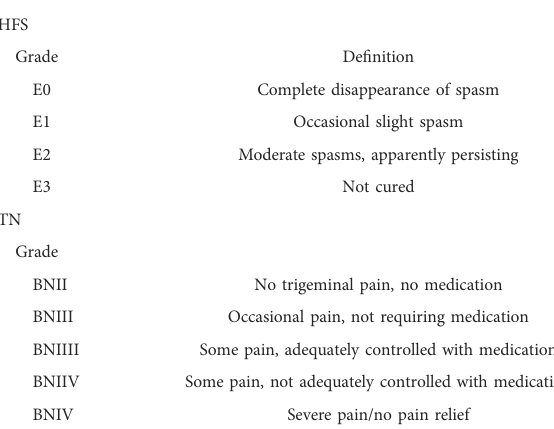
Table 4 . The correlation coef fi cient was − 0.1601 ( p = 0.7094) between SD of SBP and the Hemphill Score, − 0.2422 ( p = 0.5633) between the CV of SBP and the Hemphill Score, − 0.0272 ( p = 0.9489) between the range of SBP and the Hemphill Score.